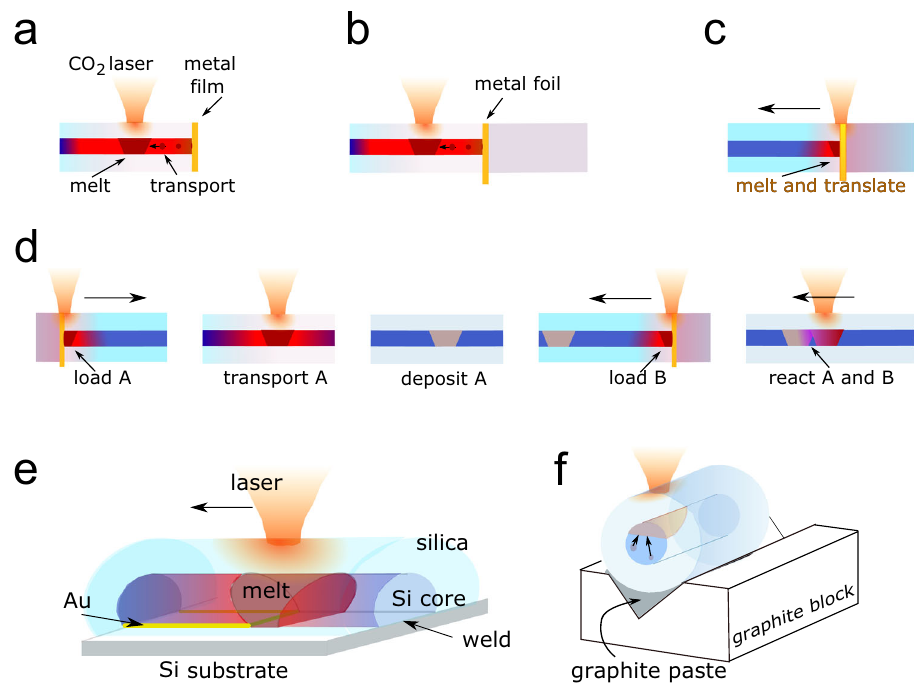
Fig. 1 Schematic of sample preparation methods. a Thermomigration of metal from a fi lm deposited on the fi bre end, driven by CO 2 laser heating, b thermomigration from a metal foil pressed against the semiconductor core fi bre. These methods allow incorporation of small amounts of metal for zone re fi ning or doping. c Bulk dissolution of a foil into the semiconductor core, followed by translation, useful where a longitudinal electrode formation is desired, d sequential introduction steps used to drive in-core formation of compounds, e use of solvent (Au) fi lm and travelling melt zone to weld the silicon core of a fi bre to a silicon substrate, and ( f ) use of graphite as a thermal sink to establish a strong vertical component to the thermal gradient, allowing thermomigration segregation of eutectic components within the fi bre